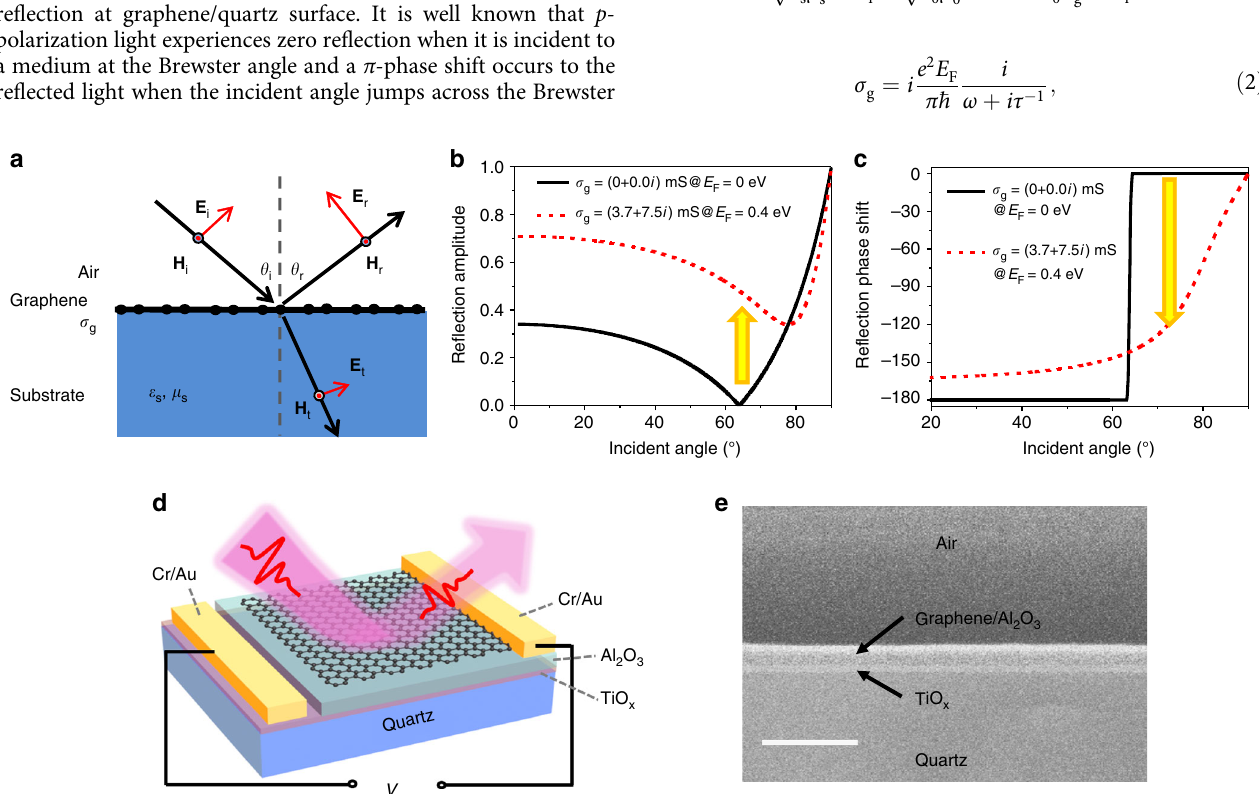
Fig. 1 Optical arrangement and device con fi guration. a Optical path diagram of the incident light from air to graphene/substrate medium. b The re fl ection amplitude and ( c ) phase as a function of incident angle, when the graphene conductivity is at 0 and 3.7 mS. The yellow arrows indicate the modulation of intensity and phase. d The three-dimensional (3D) diagram of the device, and ( e ) the SEM image of the cross section of the device. The scale bar is 5 µ